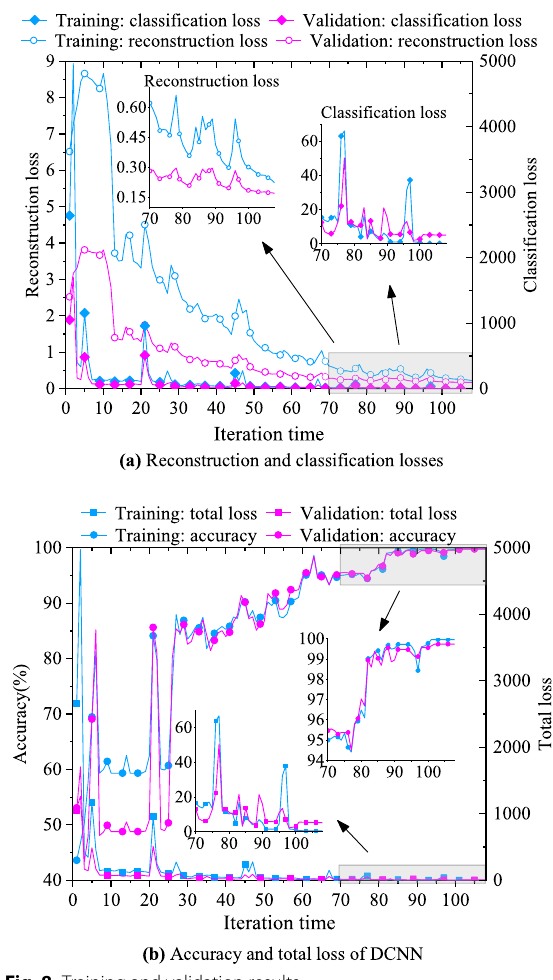
Figure 8 details the training process of the selected DCNN with weights of 1.5 and 1.0. According to Fig. 8a, the reconstruction and classification losses decrease gradually as the iteration time increases. As shown in Fig. 8b, when the iteration progresses to the 100th time, the total losses of the training and validation samples drop to below 0.1 and 20, respectively. Figure 9 shows the reconstruction results of several VICur images in the validation samples, indicating that the CAE block of the DCNN extracts the unsaturated features effectively. The classification accuracies of the training and validation samples increase to 99.96% and 99.68%, respectively. It indicates that the CNN block of the DCNN has the desired classification